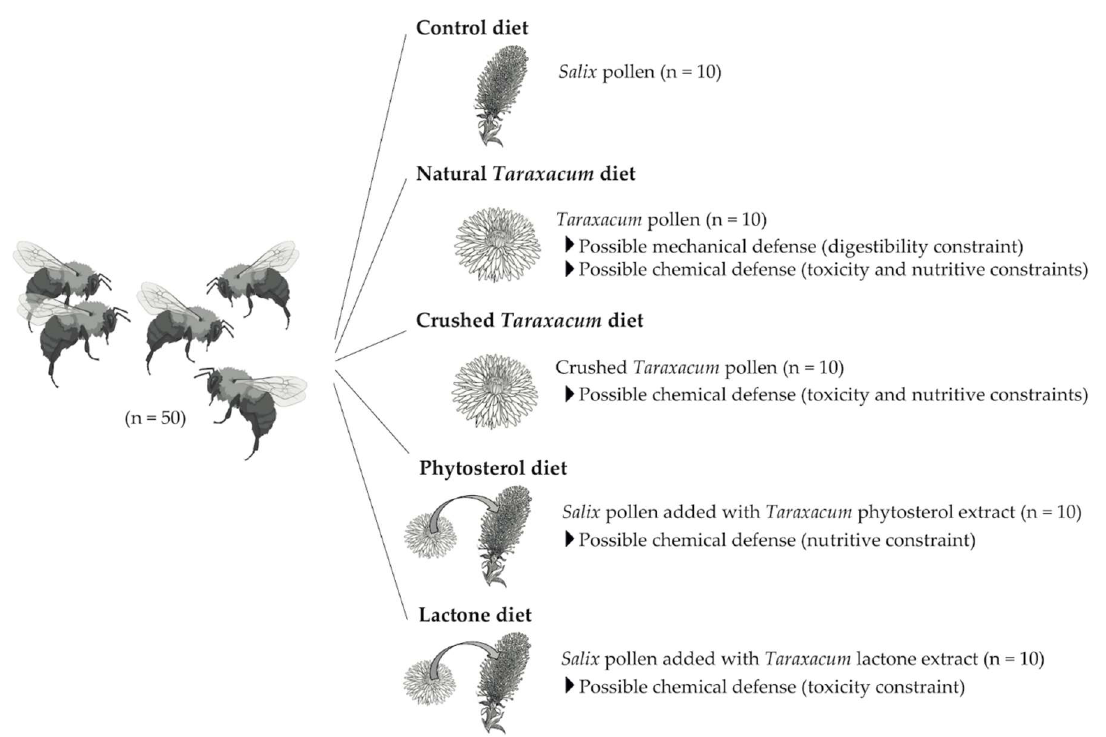
Figure 1. Experimental design and summary of diet treatments provided to B. terrestris . Each micro-colony consisted of 5 workers fed for 35 days. Mortality, offspring production, and resource collection (i.e., pollen and syrup) were monitored during or at the end of the bioassays.